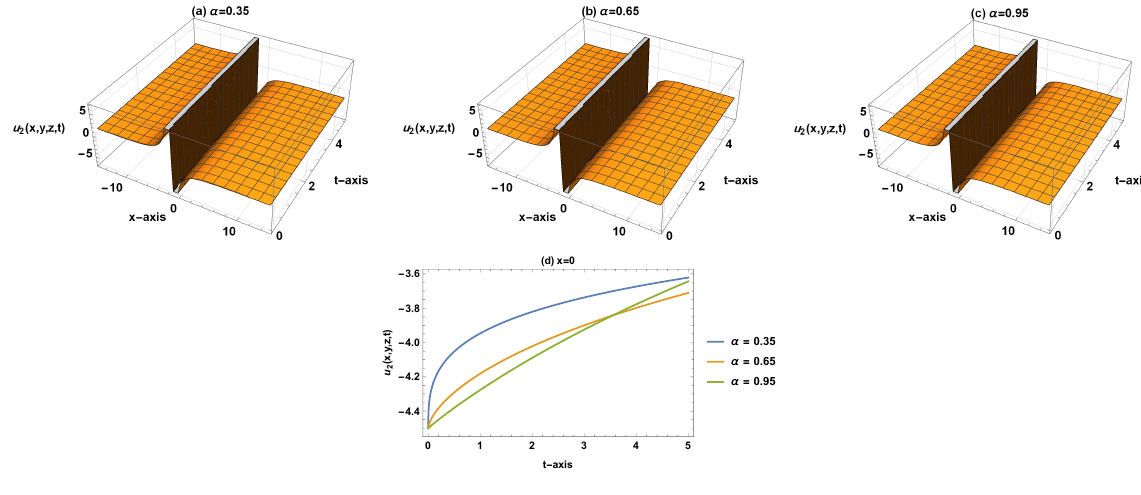
Fig. 1: (a)-(d) The wave solution u 1 ( x , y , z , t ) given by (17) in 3D-and 2D-plots when y = z = 0 .